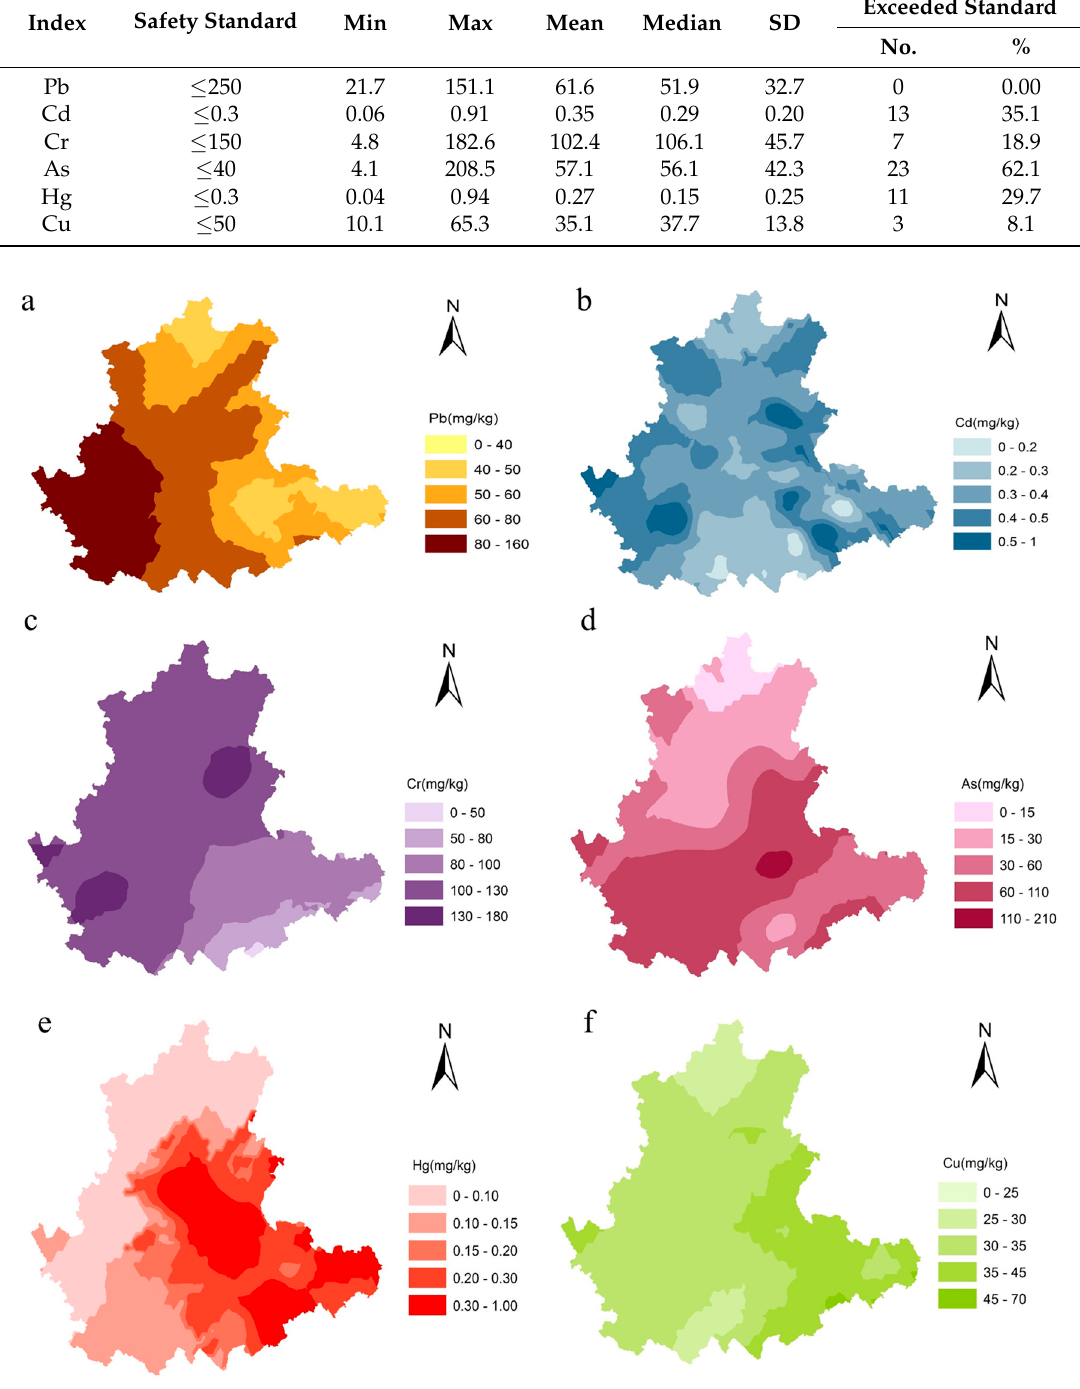
Figure 2. Spatial distribution maps of Pb ( a ); Cd ( b ); Cr ( c ); As ( d ); Hg ( e ) and Cu ( f ) in top soil in the survey area( created by Geo-statistical Analysis Kriging of ArcGIS 10.2 program ).